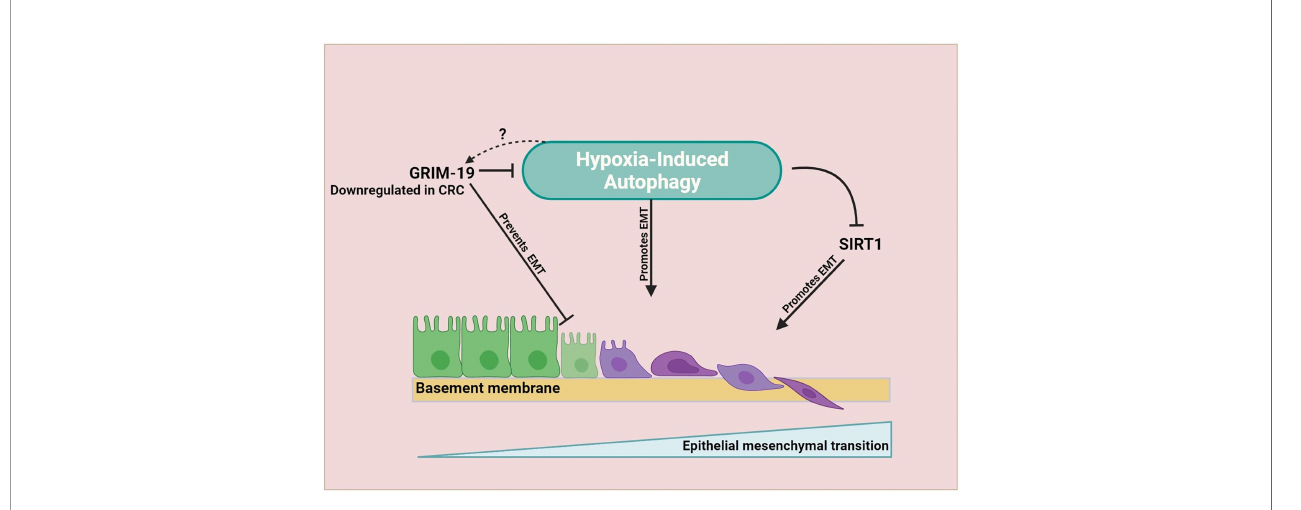
FIGURE 2 | EMT is promoted by hypoxia-dependent autophagy in CRC. As the tumor progresses, hypoxia becomes more prevalent. A growing tumor triggers autophagy as an adaptive survival mechanism. Autophagy increases the plasticity of tumor cells, causing them to acquire mesenchymal characteristics. In CRC hypoxia-induced autophagy target SIRT1 promotes EMT process and hypoxia-induced autophagy inhibition by GRIM-19 prevents EMT. However, whether hypoxia- induced autophagy can upregulate itself by downregulating the expression of GRIM-19 is not